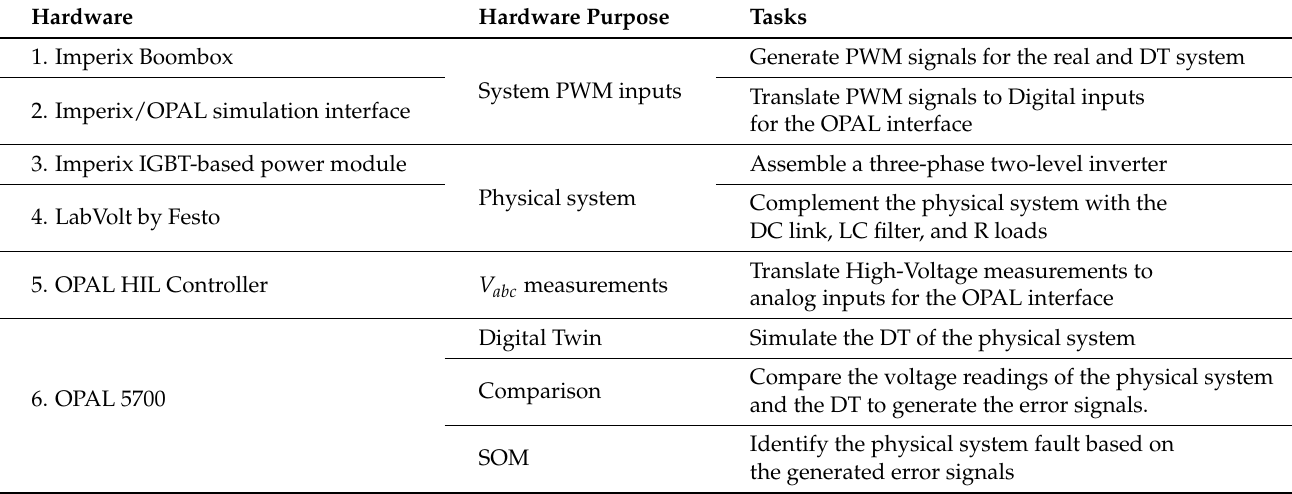
Table 6. Hardware purpose and system